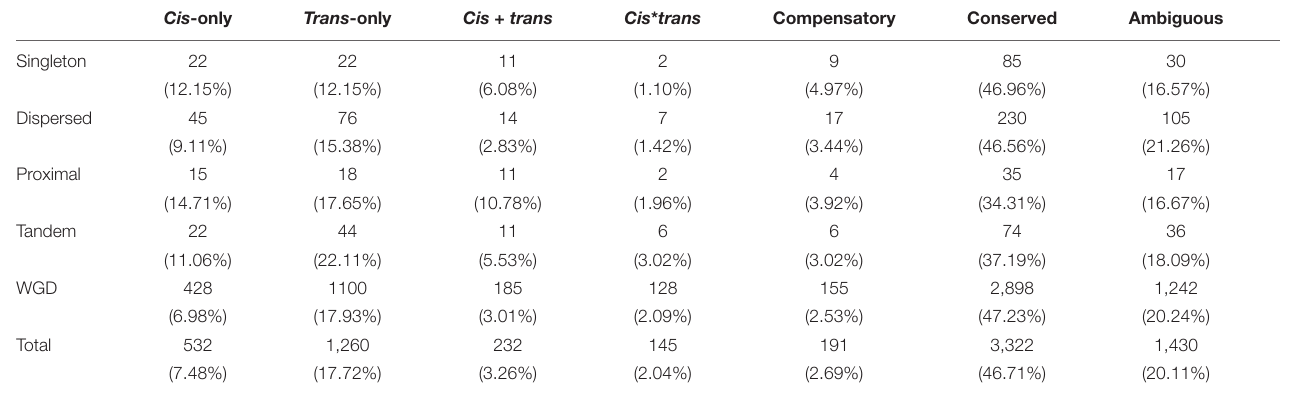
TABLE 2 | Number and proportion of genes in different regulatory patterns for each duplicate